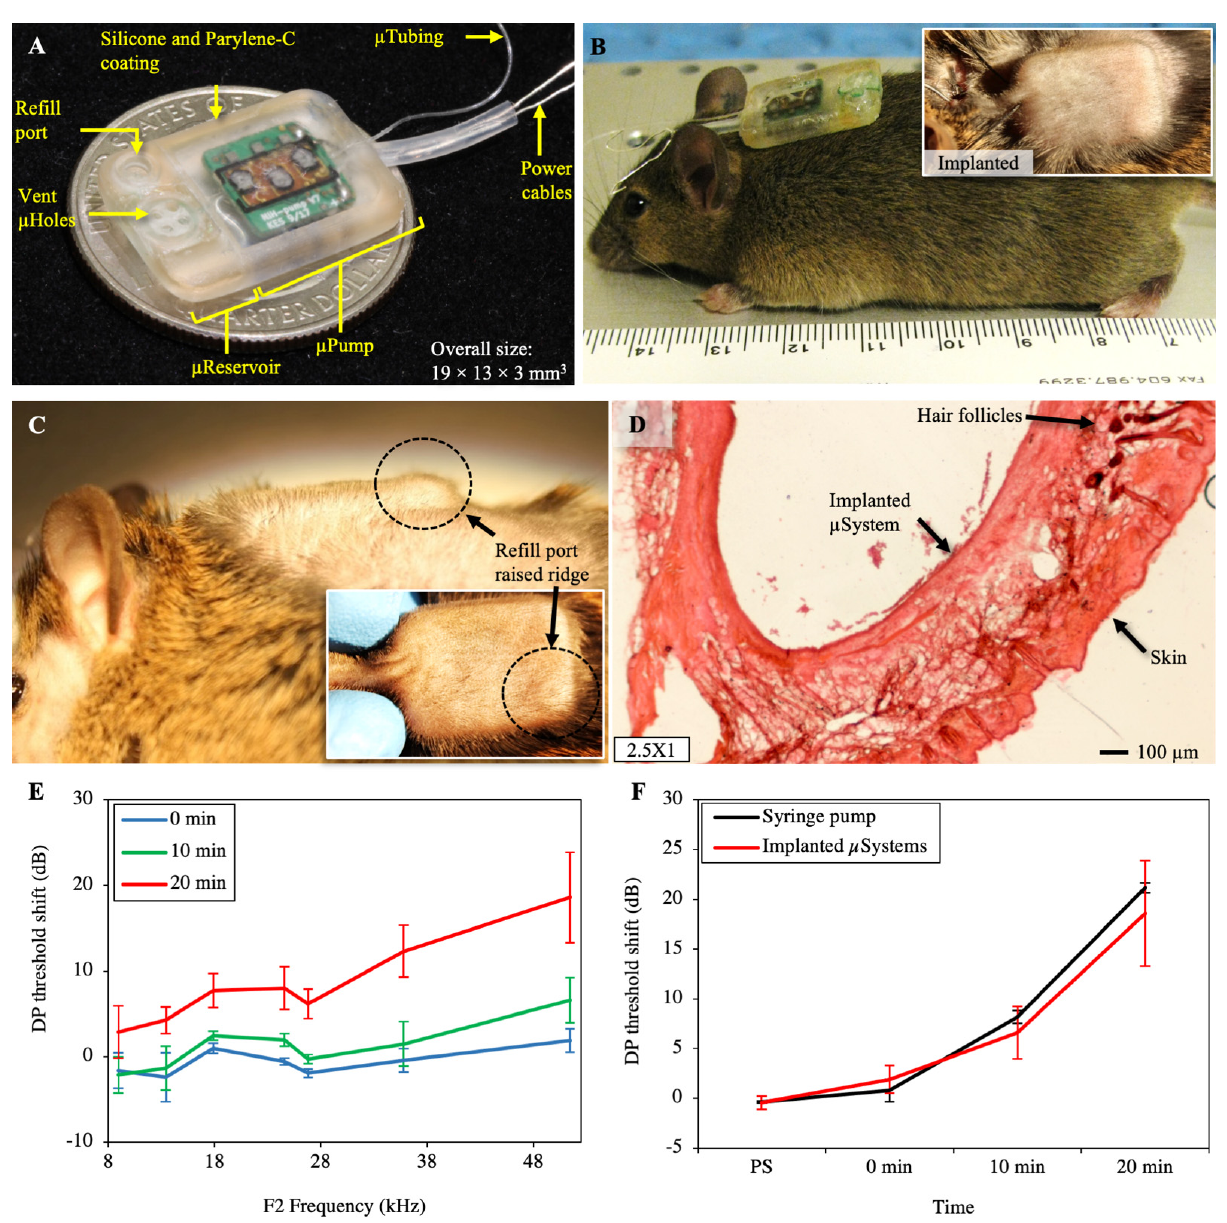
Figure 3. ( A ) Photograph of a completed microsystem with a 10 µ L microreservoir and a micropump working in the range of 10–100 nL/min. This configuration of the microsystem was optimized for subcutaneous implantation in mice with an overall thickness of 3 mm. ( B ) Photograph of a microsystem before implantation demonstrating the width of the microsystem optimized for subcutaneous implantation in mice. Inset: An image of the microsystem after implantation via insertion of the microsystem in a small incision made in the center of the upper back of a mouse. ( C ) Side view and top view (inset) of a microsystem implanted showing the visibility of the refilling port. ( D ) A representative 60 µ m section of the skin surrounding the microsystem showed no sign of any active inflammatory cells. A fibrotic layer (pink tissue) fully encapsulated the microsystem. ( E ) DPOAE threshold shifts (mean ± standard error of the mean) from four mice recorded from 0 to 20 min after the start of a salicylate infusion showed a systemic increase in DPOAE thresholds, demonstrating successful delivery of salicylate to the cochlear. ( F ) Results of the threshold shift (mean ± standard error of the mean) of the most basal region (F2 = 51.4 kHz) for implanted microsystems and the syringe pump showed perfect consistency, demonstrating the successful performance of the microsystem ( n = 6 for syringe pumps, n = 4 for microsystems). PS: post surgery; 0 min: right after starting the pump; 10 and 20 min: 10 and 20 min after starting the infusion.